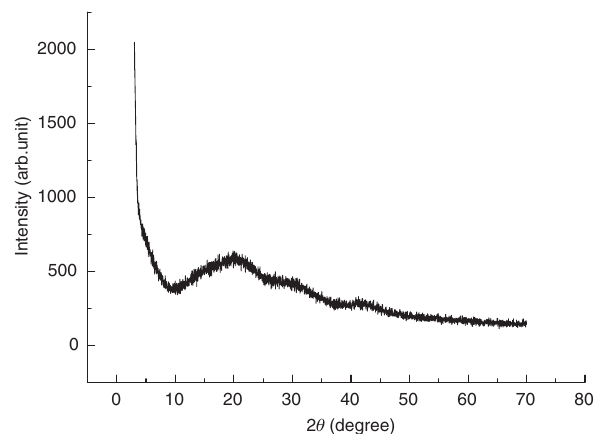
Figure 8 Contrast curve of the tensile strength and bending strength as a function of the high dispersibility nano-silica powder content.